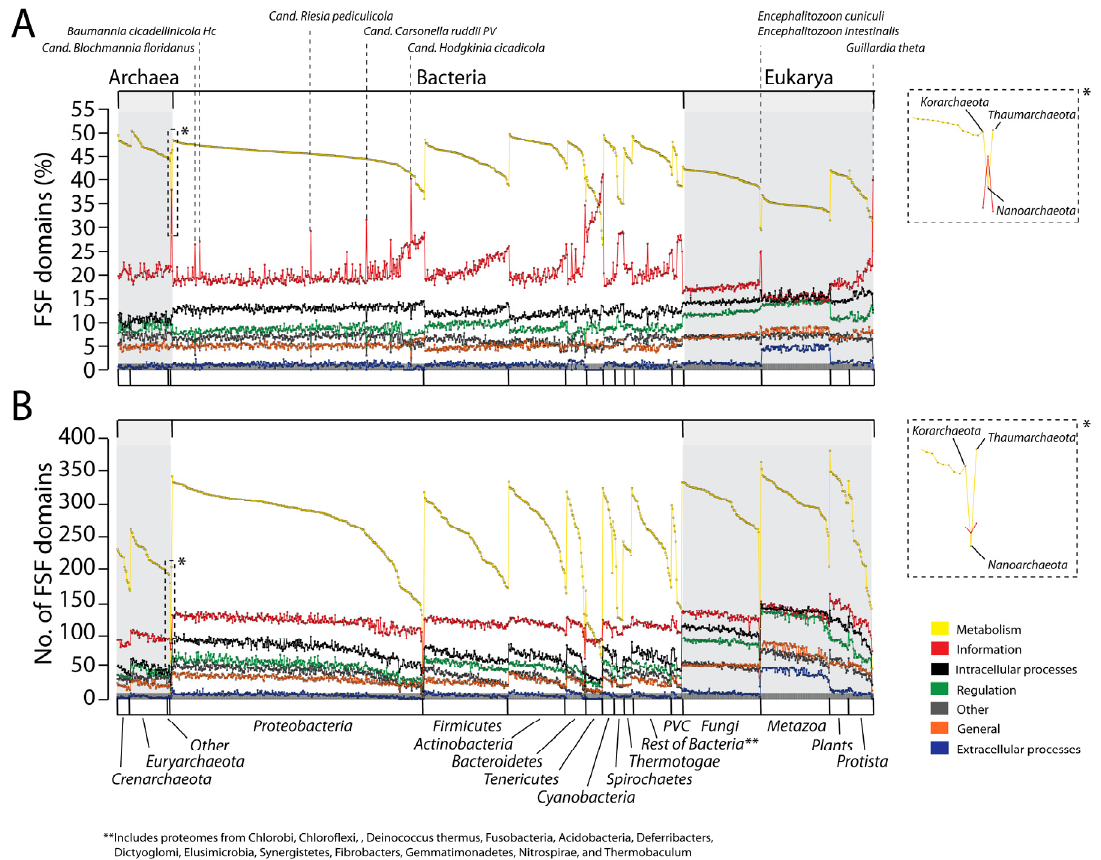
Figure 2. The functional distribution of FSFs in individual proteomes of the three superkingdoms. Both the percentage ( A ) and actual FSF numbers ( B ) indicate conservation of functional distributions in proteomes and the existence of considerable functional flexibility between superkingdoms. Dotted vertical lines indicate genomic outliers. Insets highlight the interplay between Metabolism (yellow trend lines) and Information (red trend lines) in N. equitans